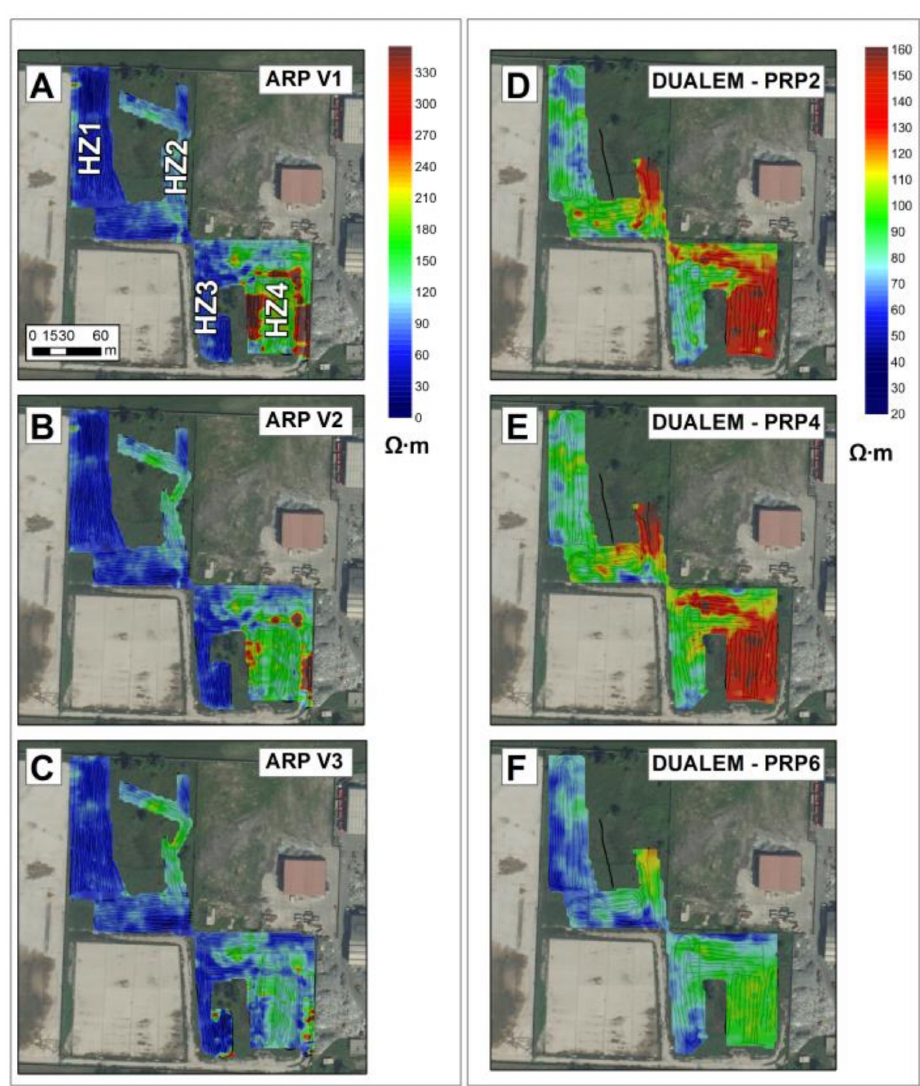
Figure 2. Maps of apparent electrical resistivity (ERa) obtained by ARP ( A – C ) and DUALEM ( D – F ) surveys for the investigation of different soil depths. ( A ) V1 = 0–0.5 m; ( B ) V2 = 0–1 m; ( C ) V3 = 0–1.7 m; ( D ) PRP2 = 0–1 m; ( E ) PRP4 = 0–2 m; ( F ) PRP6 = 0–3